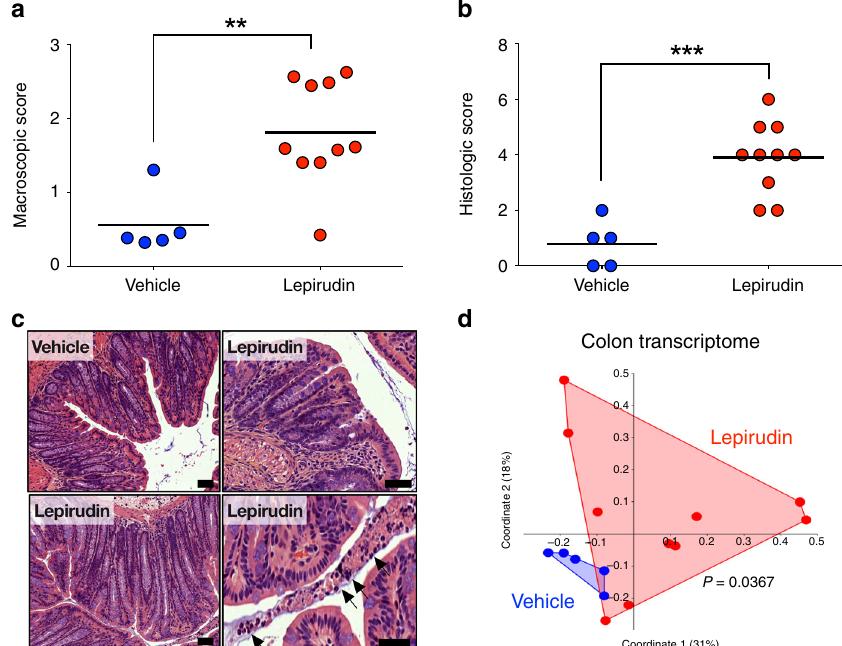
Fig. 3 Intestinal homeostasis is compromised by inhibition of thrombin activity in colon lumen. C57Bl/6 mice were treated daily with either vehicle ( n = 5) or lepirudin ( n = 10, 10 µ g/day) via intracolonic route, euthanized after 10 days and used for further analysis ( a – d ). a Macroscopic (Wallace scoring endpoint 58 ) and b . Microscopic damage scores 49 in lepirudin-treated group were signi fi cantly greater than the scores measured in vehicle controls. a , b Data are represented as scatter plot with the mean bar. Unpaired Mann – Whitney two-tailed test *** P < 0.001 c Hematoxylin-eosin images revealed a normal histology in vehicle-treated group, while in lepirudin-treated group, we observed crypt elongation (lower left panel), areas with goblet cell depletion (upper right panel), as well as neutrophils transmigration in the lumen (lower right panel, arrows). Scale bars represent 50 µ m. Representative images of vehicle ( n = 5) and lepirudin-treated ( n = 10) group are reported. d Transcriptome analysis of Muc2 , Camp , Tff3 , Defb4 , Reg3g , Reg3b , Cox2 , Nos2 , Tnf , Ifng , Cxcl1 , IL17a , Adgre1 , IL1b , Cldn1 , Cldn2 , Cldn5 , Tjp1 Zo1 and Ocln genes was performed by qPCR. Principal coordinate analysis with Bray-Curtis dissimilarity matrix illustrates distances between each mouse transcriptome (each dot represents an individual mouse transcriptome), and demonstrate a signi fi cant separation between vehicle and lepirudin-treated group. PERMANOVA Bonferroni corrected P =